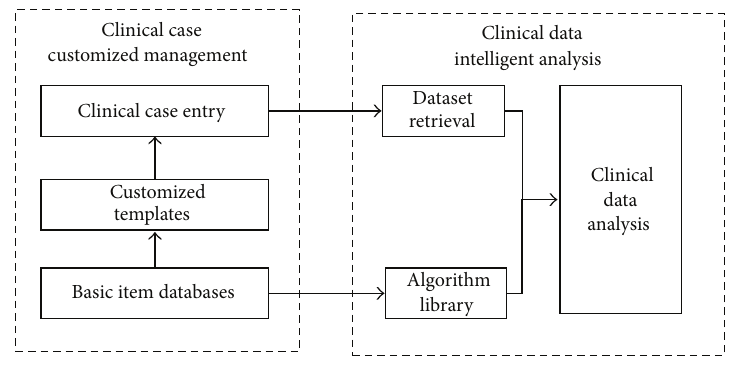
Figure 1: Functional overview of the